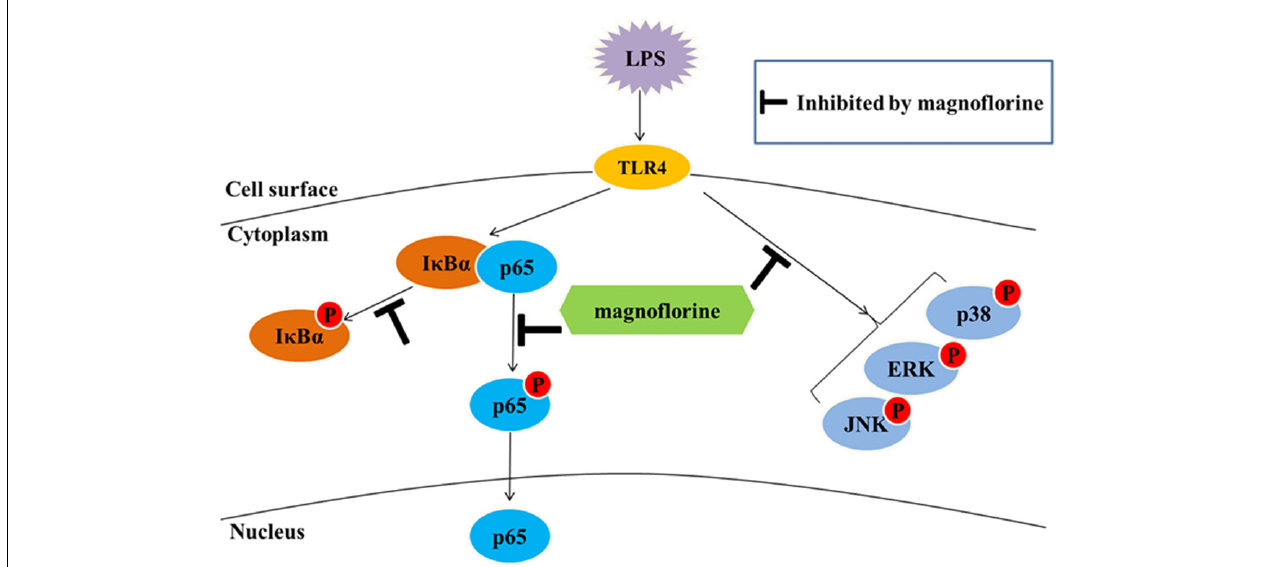
FIGURE 9 | NF- κ B and MAPK pathways in LPS-stimulated